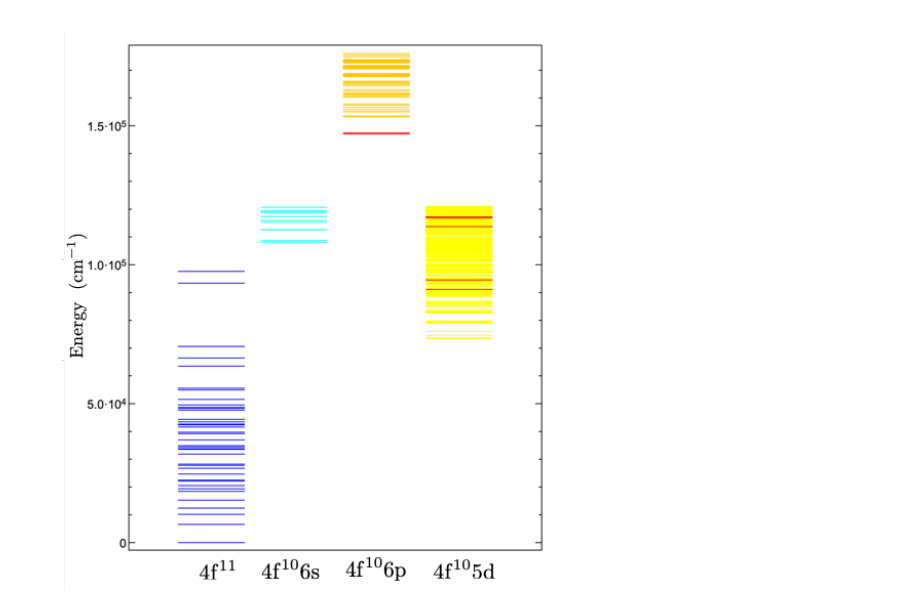
Figure 3. Energy levels of Er 3 + calculated with the Cowan codes [4]. The candidates of the upper levels for the observed transitions are shown as red lines in this figure. The energy levels at 147,062.3 and 147,473.8 cm − 1 and those at 116,918.7 and 117,197.3 cm − 1 cannot be shown as separated lines because of their small energy